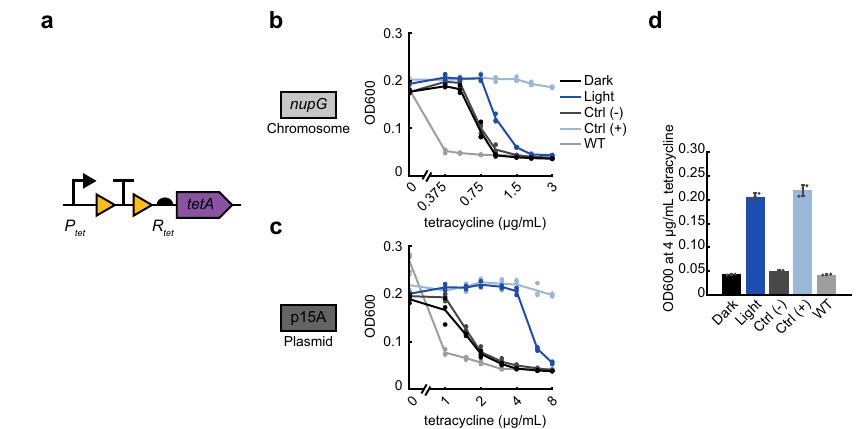
d Optimal OptoCre- tetA activation conditions, using the p15A plasmid origin at 4 µ g/mL tetracycline. Growth is quanti fi ed by OD600 after 18h. Error bars show standard deviation around the mean ( n =3 biological